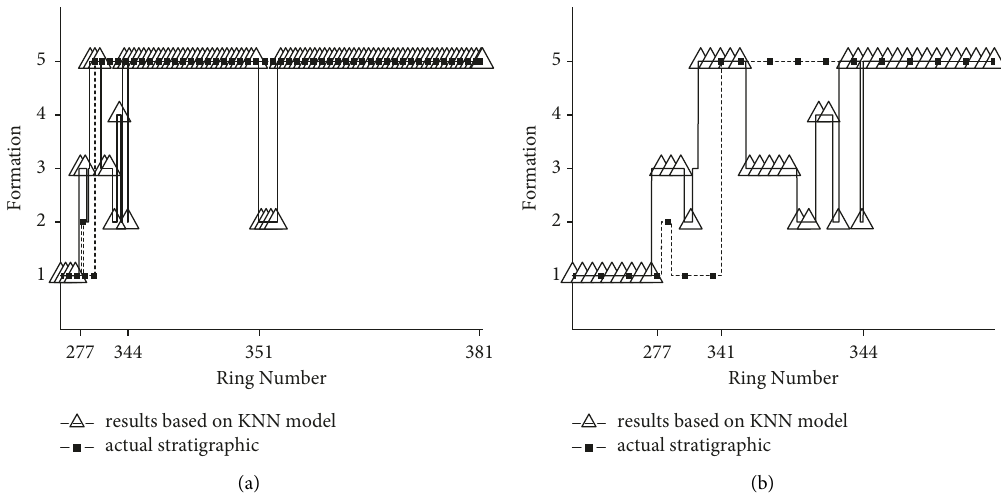
Figure 8: Formation recognition results based on the KNN model and actual stratigraphic correlation map. (a) Formation identification results of KNN model to test set. (b) Partially enlarged